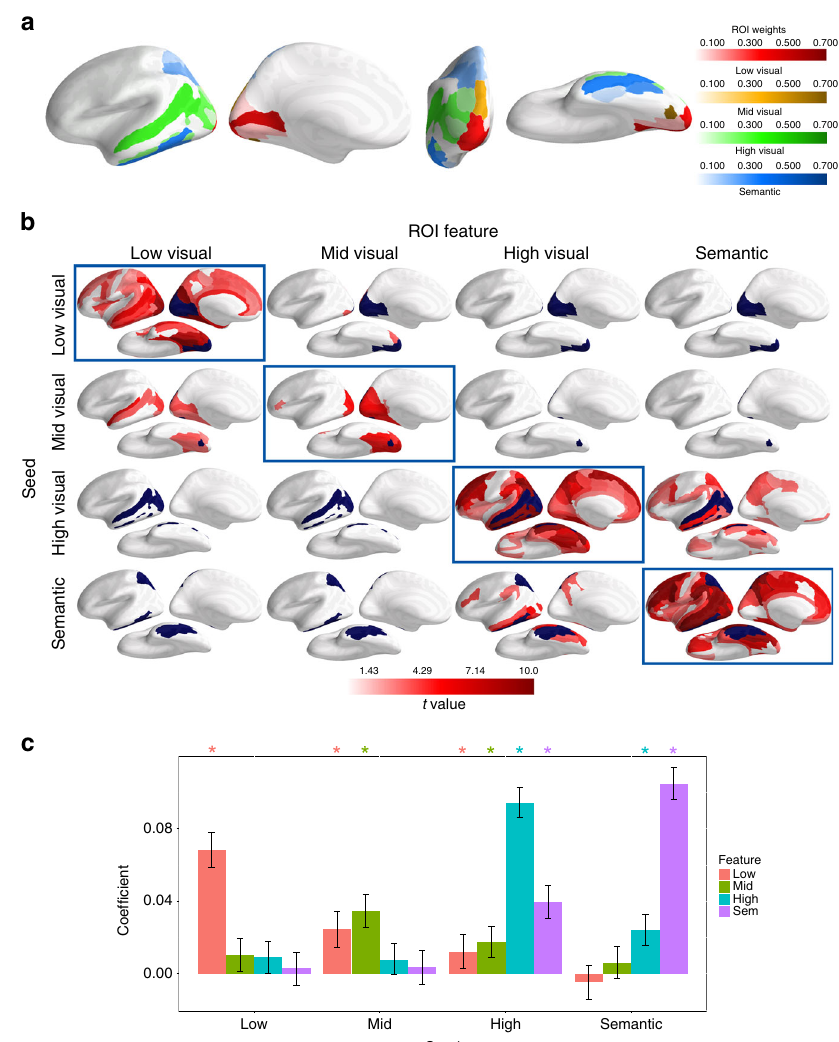
Fig. 4 Seed ROI weights and feature-speci fi c informational connectivity during episodic recall. All ROIs are bilateral. a Seed ROI weights for each feature level. Seed ROI weights are proportional to the decoding accuracy for the target feature level relative to the other feature levels during perception of the recognition probe (i.e., the relative accuracy peaks). b FSIC results for all combinations of seed ROI/feature-level and target ROI feature-level. For FSIC, neural reactivation (during memory recall) of each feature level within the corresponding seed ROI (rows; seed ROIs colored dark blue) was correlated with reactivation of all four feature levels (columns), controlling for the reactivation of the non-target feature levels, within all ROIs except for the seed. The t - values associated with those correlations are indicated with shades of red and thresholded at p < 0.05, one-tailed bootstrap, FDR corrected. c The partial correlation coef fi cients from b averaged over all ROIs (note: this graph is not conceptually the same as Fig. 3b — this is not possible because we do not know a priori what features are represented in the ROIs). Error bars are 90% CIs; *indicates p < 0.05, one-tailed bootstrap, FDR